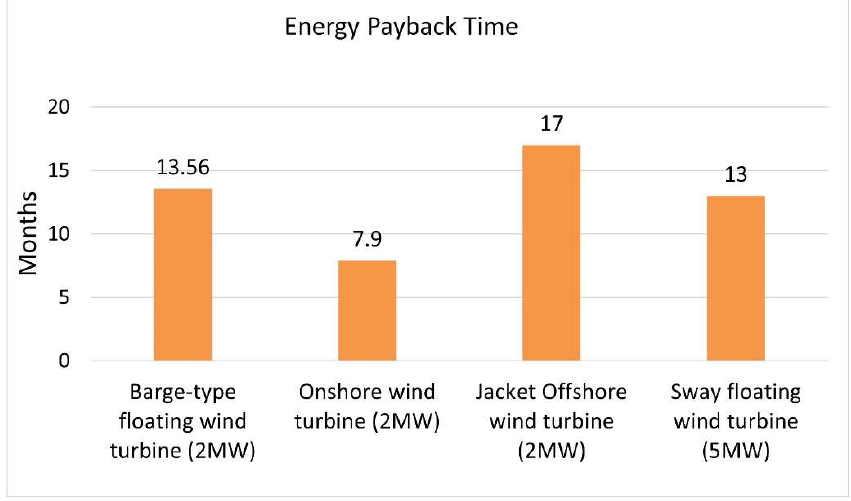
Figure 9. Energy payback time for floating, onshore, and offshore wind turbines.